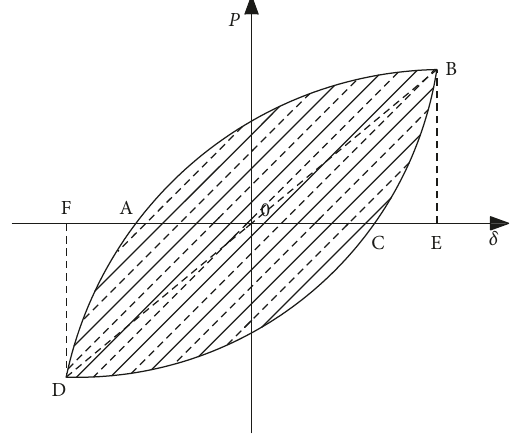
Figure 9: Load-displacement